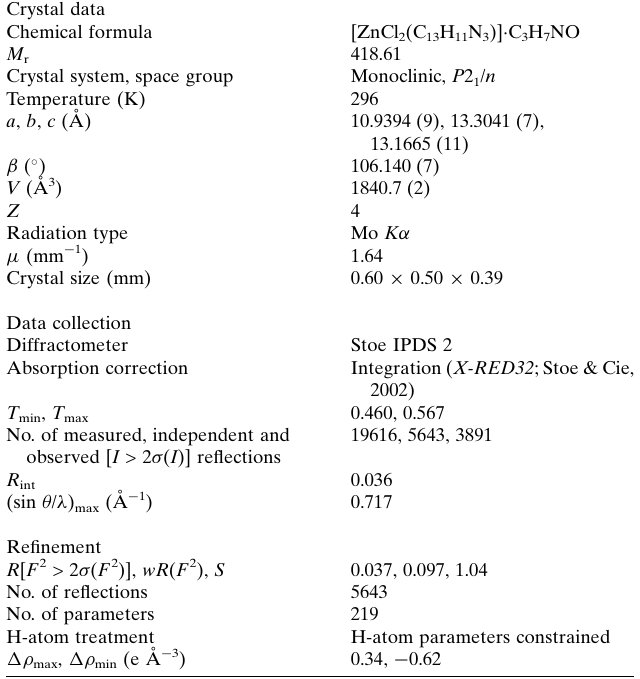
Table 2 Experimental details. Crystal data Chemical